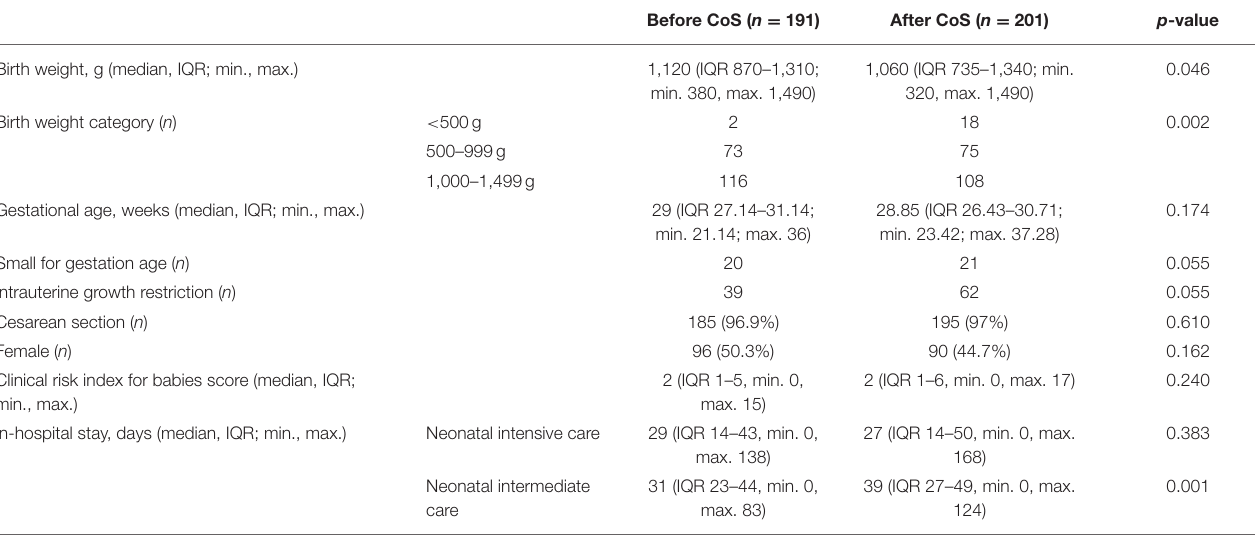
TABLE 1 | Comparison of very low birth weight infants characteristics between the two cohorts before and after the introduction of colonization screening (CoS). Before CoS ( n = 191) After CoS ( n = 201) p -value Birth weight, g (median, IQR; min.,